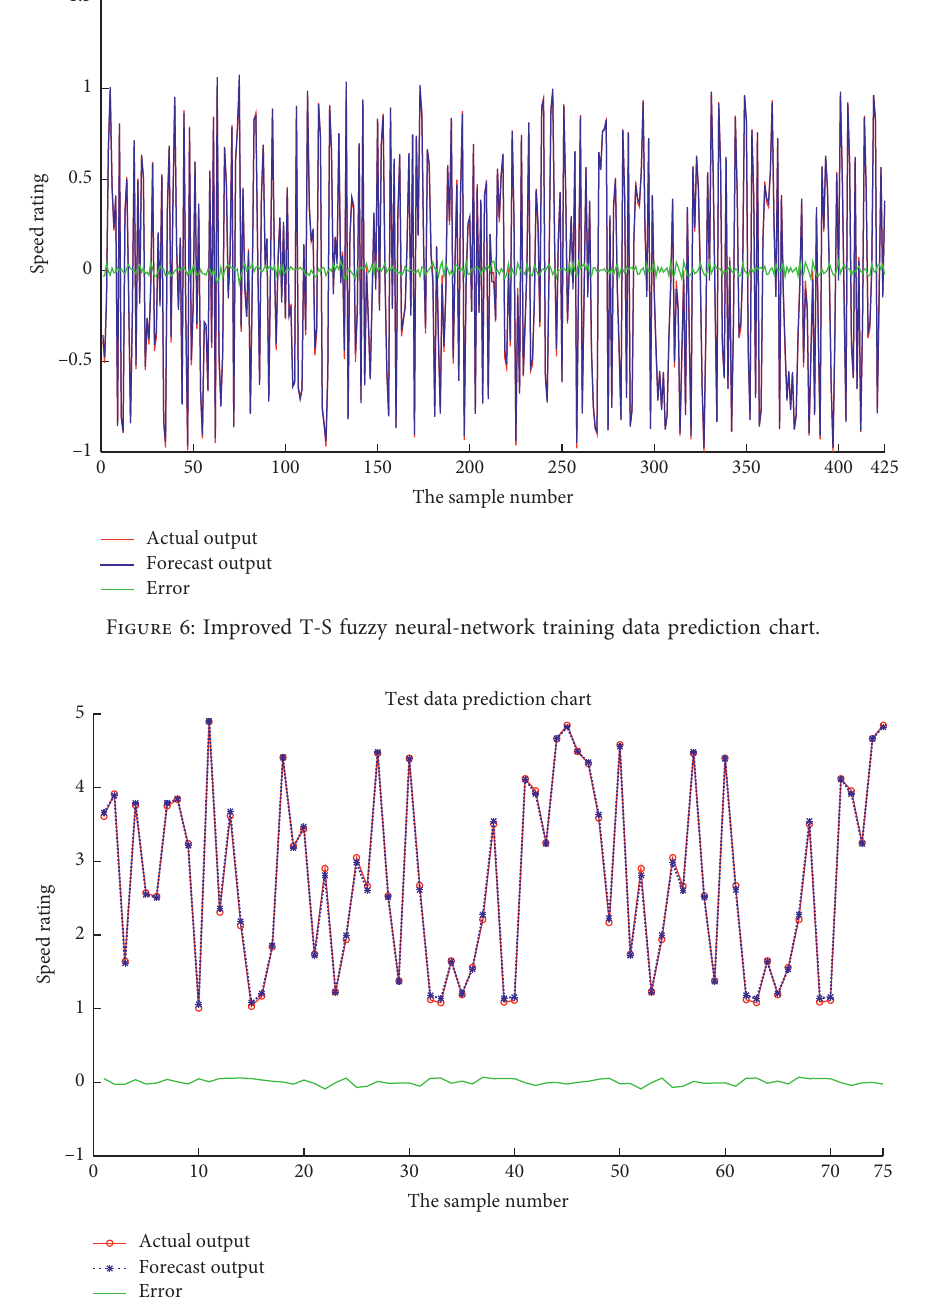
Figure 7: Improved T-S fuzzy neural-network test data prediction chart.